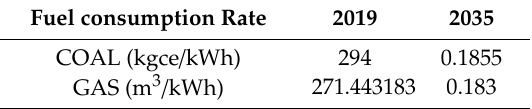
Table 10. Fuel consumption rates of the generation technologies over the planning